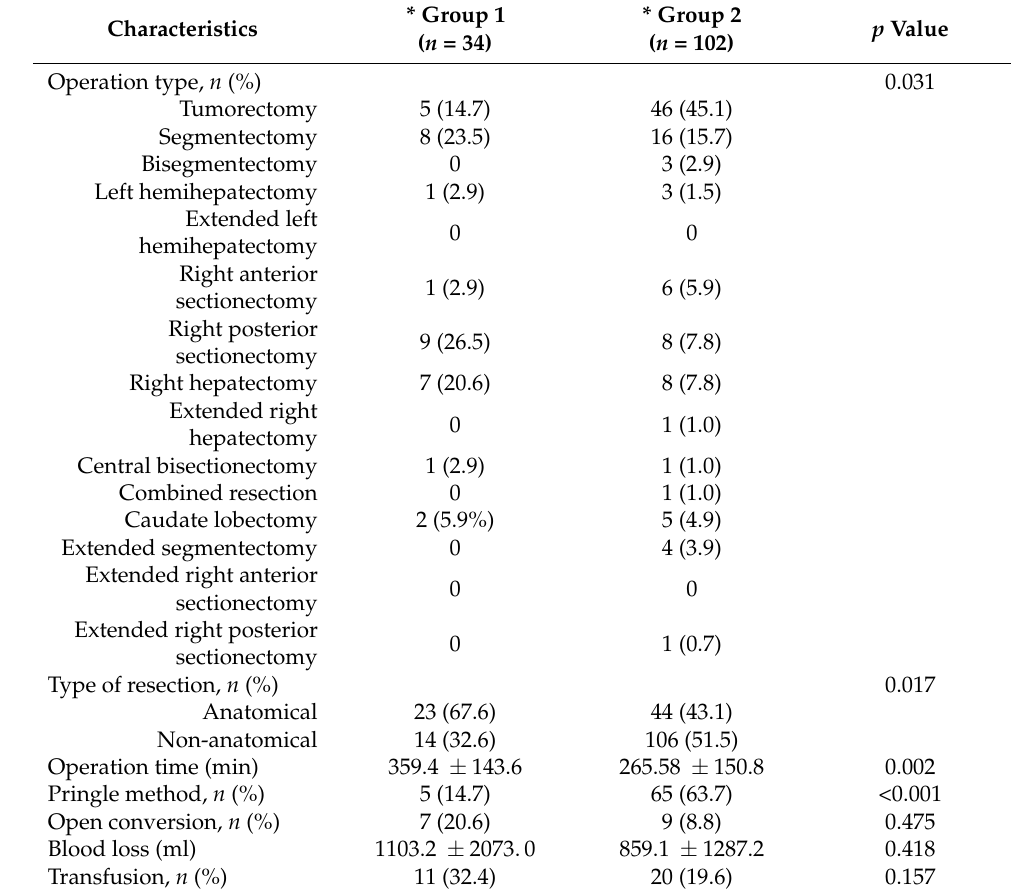
Table 2. Perioperative outcomes of laparoscopic liver resection for hepatocellular carcinoma in posterosuperior segments of the